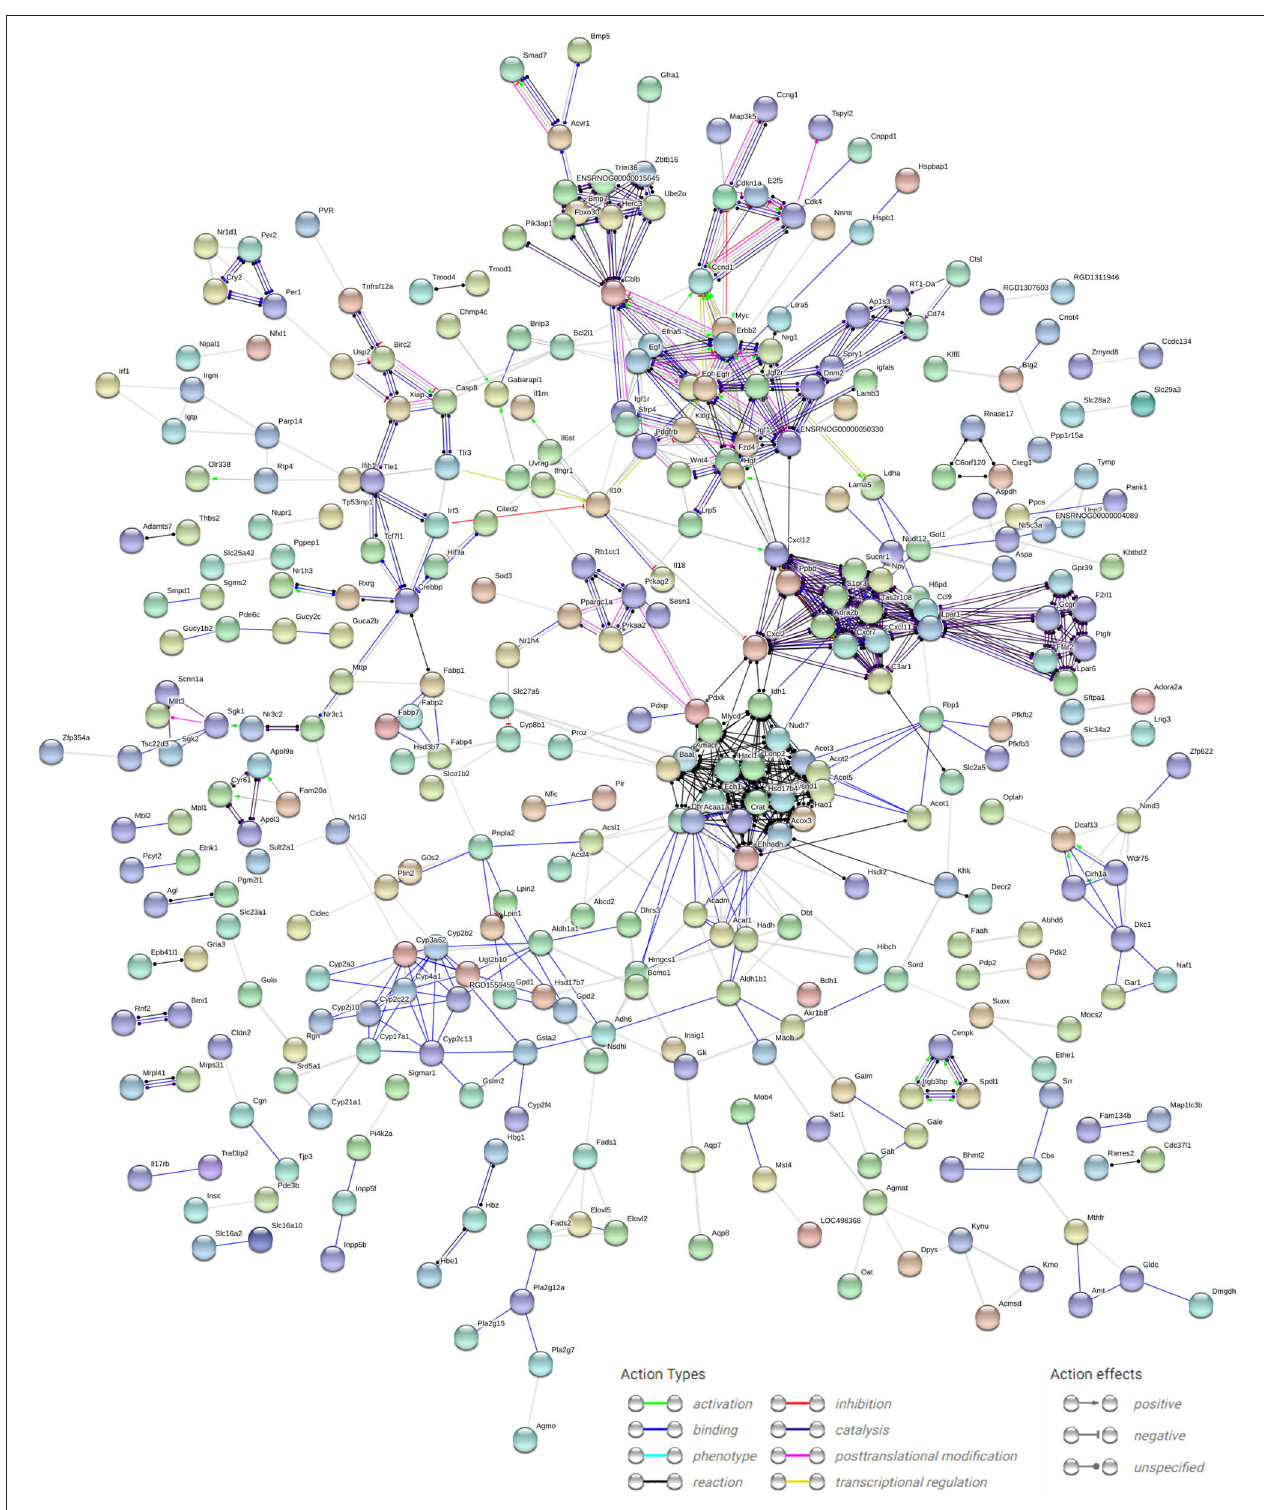
FIGURE 6 | PPI network analysis of DEGs in IUGR. The dots indicate individual differentially expressed genes, and the lines between any nodes represent the interrelations of those proteins. The PPI network was established using cut-off values of confidence score > 0.7 using default online parameter settings. We visualized the PPI network analysis of DEGs from the STRING database (version 10.5; http://string-db.org/).